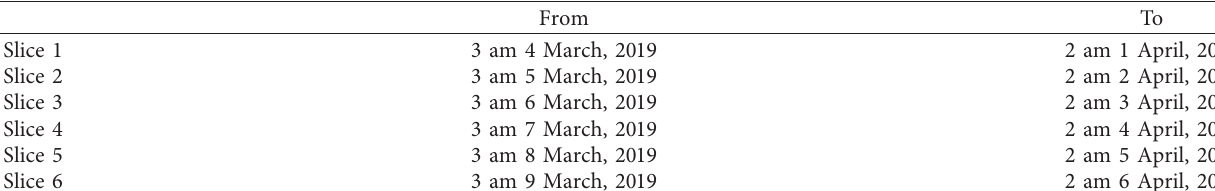
Table 2: Time periods of cross validation of each slice. From To